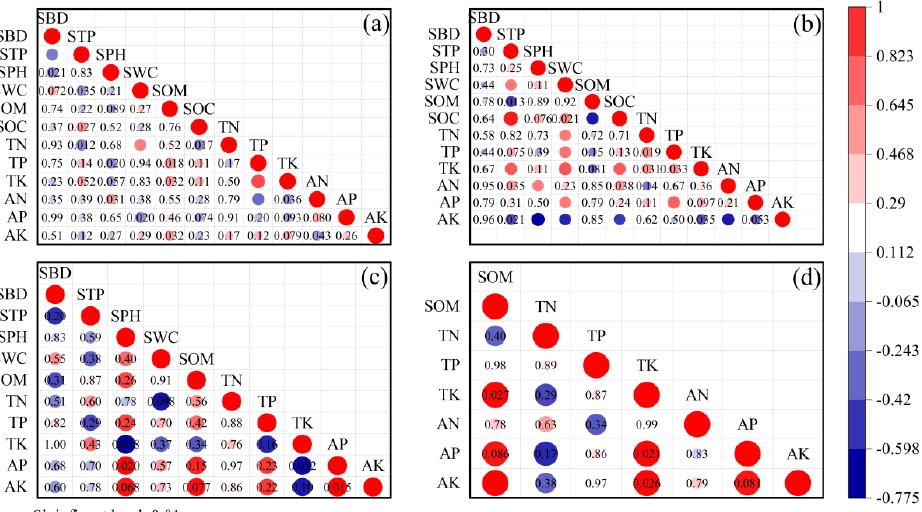
Figure 5. Correlation analysis among different soil characteristics. ( a ) the whole China region; ( b